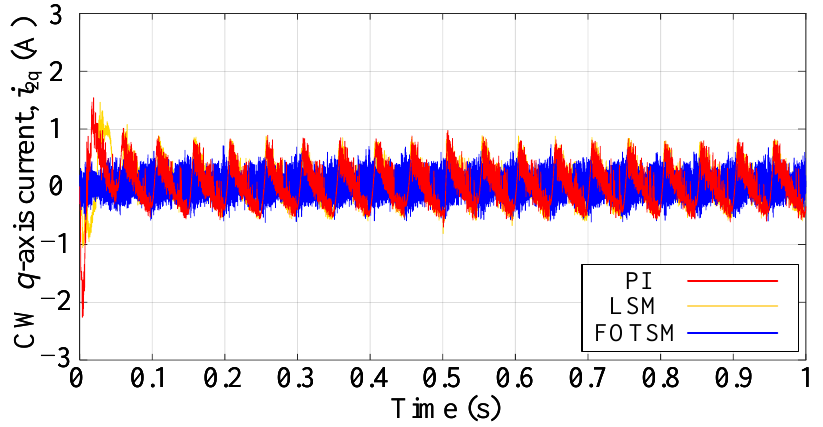
Figure 9. The CW q -axis current responses under PI, LSM, and FOTSM during the load adding process.